Question: Briefly state, in one sentence, what is plotted here.
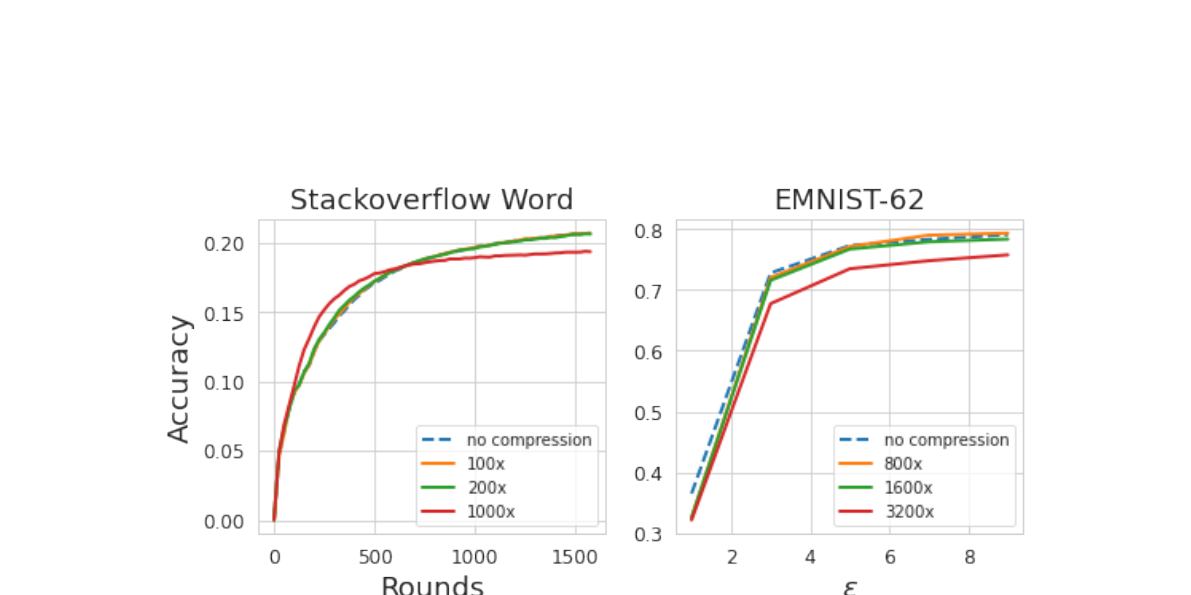
Answer: Accuracy of GM and CSGM, with δ = 10−5 for F-EMNIST and δ = 10−6 for SONWP. The resulting ∆∞/∆2 value is 6.4 · 10−3 for F-EMNIST and 3.3 · 10−3 for SONWP.